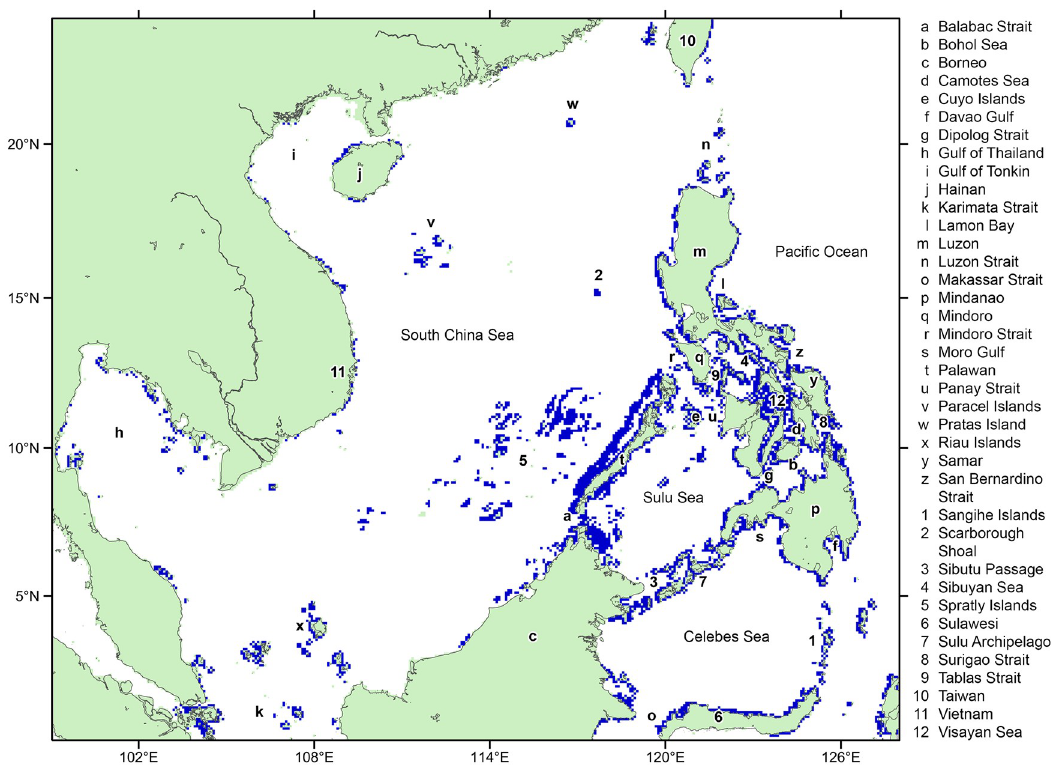
Fig 1. Study domain. Blue cells are rasterized coral reef cells derived from the UNEP World Conservation Monitoring Center (UNEP-WCMC) coral reef database [48]. Green cells are land-masked cells based on the Global HYCOM [49] and gray lines refer to the coast